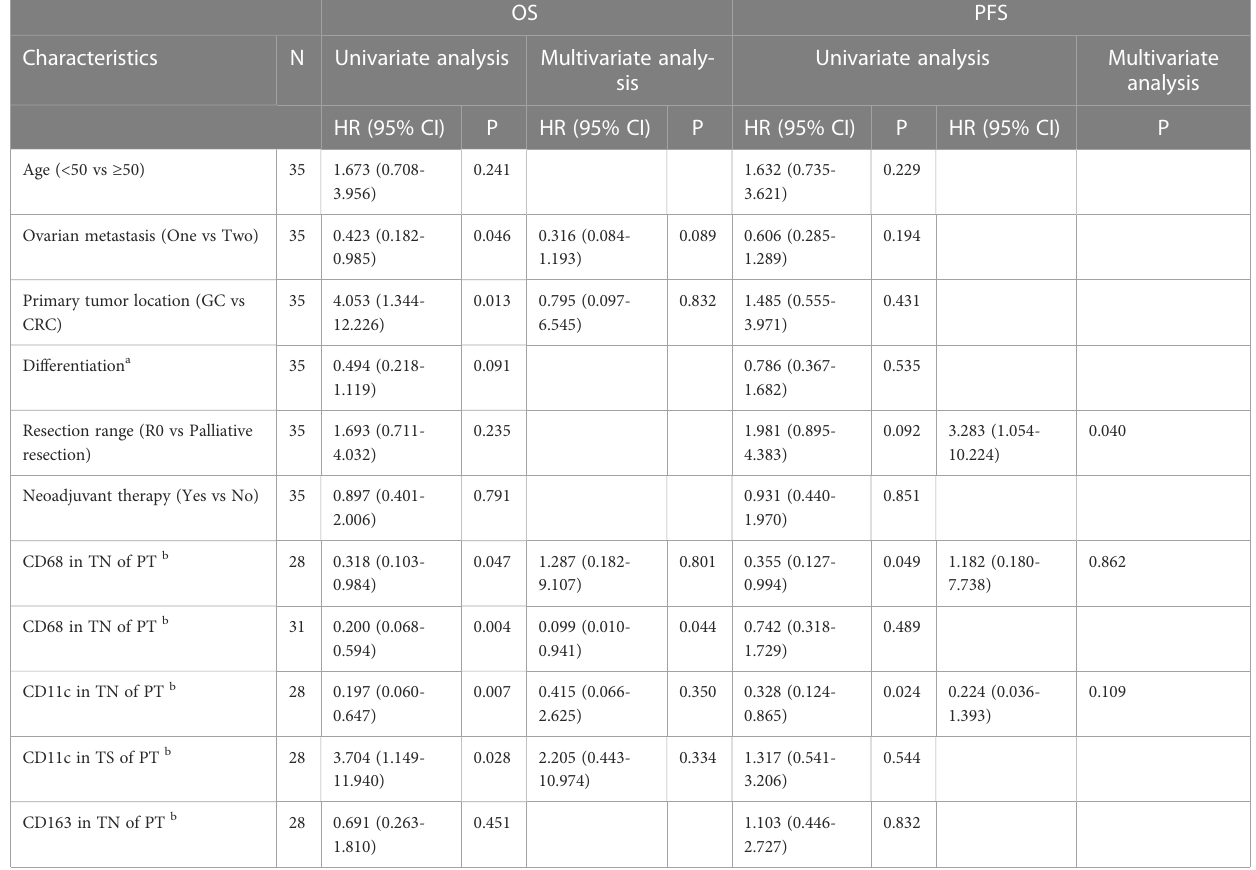
TABLE 3 Univariate and multivariate analysis of the correlation of TAMs in fi ltration and clinicopathological factors with OS, PFS among patients with KT.